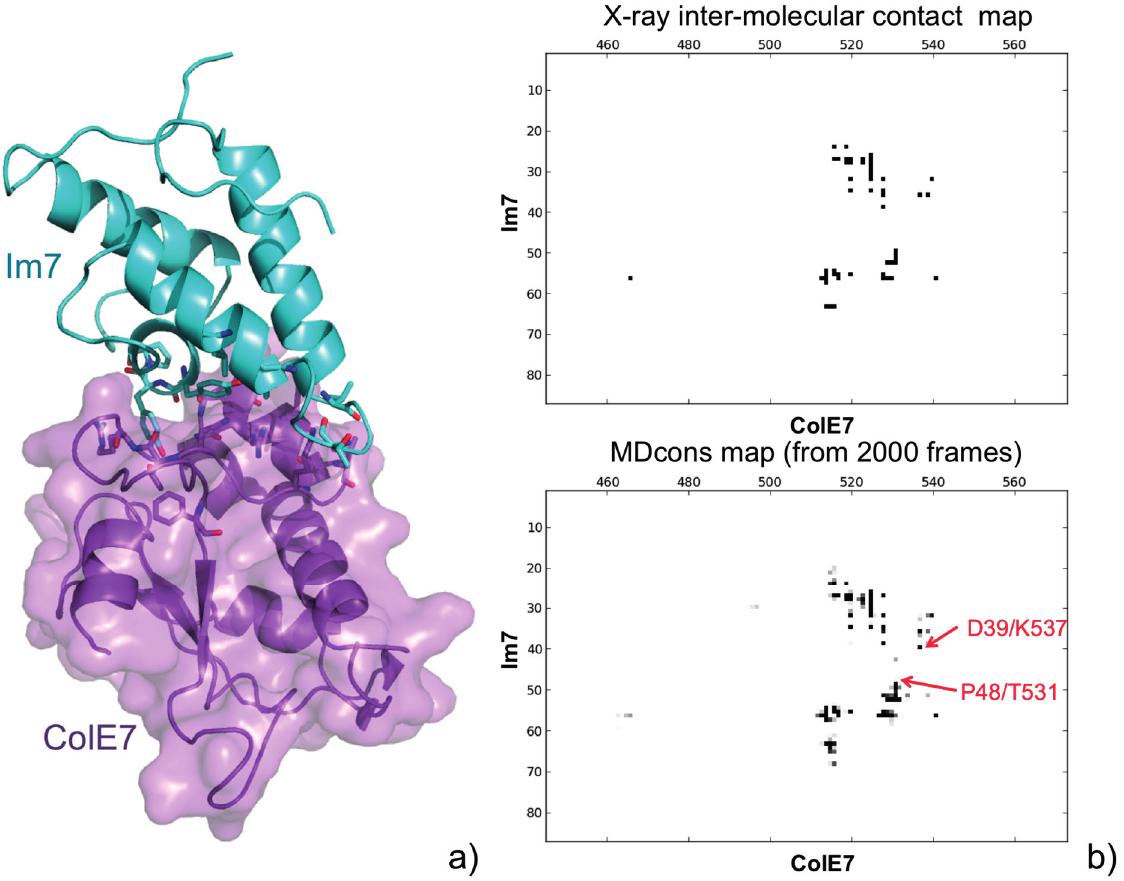
Figure 4. ( a ) A 3D representation of the Im7-ColE7 complex (PDB ID: 7CEI [43]). Residues always maintained during the MD simulations are shown in a stick representation; ( b ) Intermolecular contact map of the Im7-ColE7 X-ray structure obtained by COCOMAPS (top), and consensus map of the 2000 MD snapshots (bottom). Although the interface is quite well conserved, examples of new contacts appearing during the MD simulations are shown (in red) in the consensus